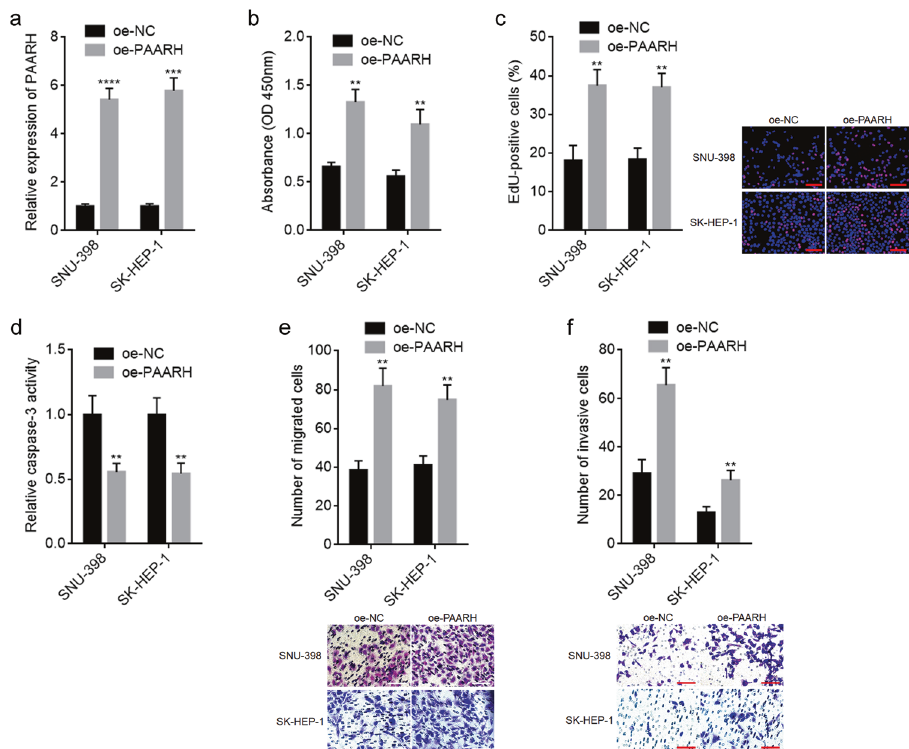
Fig. 2 Ectopic expression of PAARH enhanced HCC cellular malignant phenotype in vitro. a PAARH expression in SNU-398 and SK-HEP-1 cells with PAARH stable overexpression was measured by qRT-PCR. b Cell growth of SNU-398 and SK-HEP-1 cells with PAARH overexpression was detected using CCK-8 assays. c Cell growth of SNU-398 and SK-HEP-1 cells with PAARH overexpression was detected using EdU incorporation assays. Scale bars, 100 µm. d Cell apoptosis of SNU-398 and SK-HEP-1 cells with PAARH overexpression was detected using caspase-3 activity assays. e Cell migration of SNU-398 and SK-HEP-1 cells with PAARH overexpression was detected using transwell migration assays. Scale bars, 100 µm. f Cell invasion of SNU-398 and SK-HEP-1 cells with PAARH overexpression was detected using transwell invasion assays. Scale bars, 100 µm. Results are shown as mean ± SD based on three independent experiments. ** p < 0.01, *** p < 0.001, **** p < 0.0001 by Student ’ s t